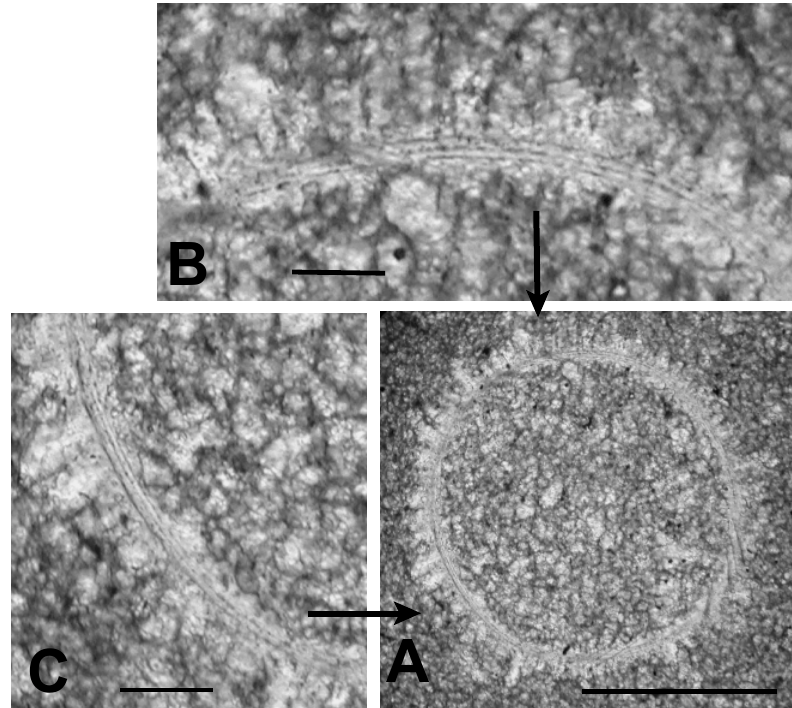
Figure 5. Microalgal cell (TYT-05) viewed in white light. ( A ) specimen in cross-section surrounded by micrite. Scale bar = 100 µm; ( B ) enlargement of the upper portion of specimen showing a multi-layered body wall defined by three thin, dark bands. Scale bar = 20 µm; ( C ) enlargement of lower left portion of specimen showing multi-layered body wall. Scale bar = 20 µm.